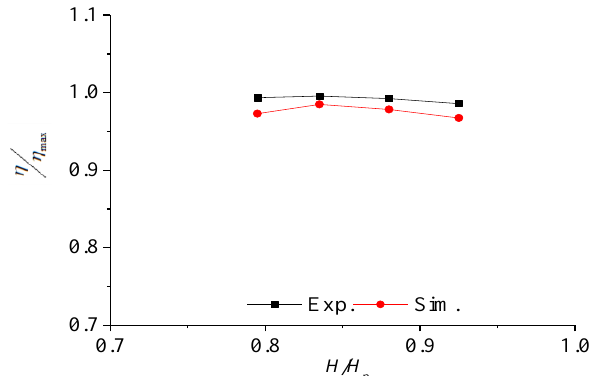
Figure 3. Comparison of numerical simulation and experimental results.